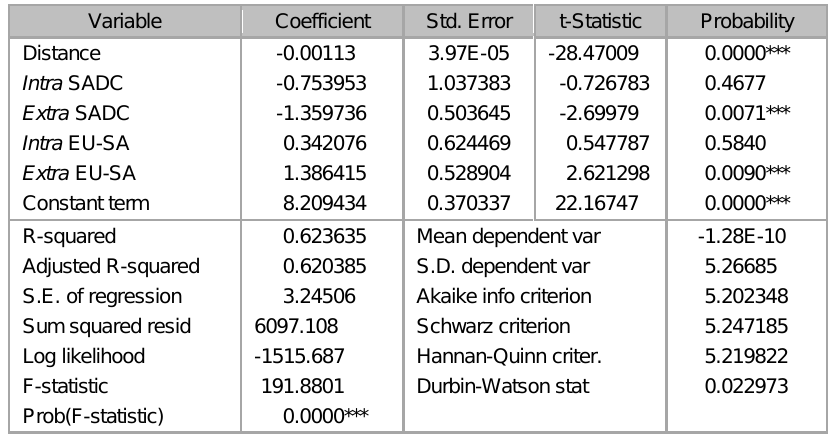
Second-stage (pooled model)